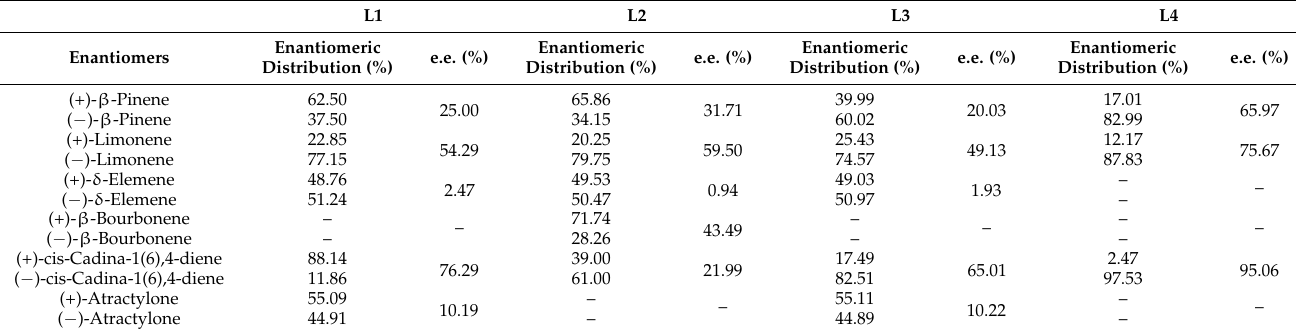
Table 2. Enantioselective analysis of Siparuna muricata essential oil.